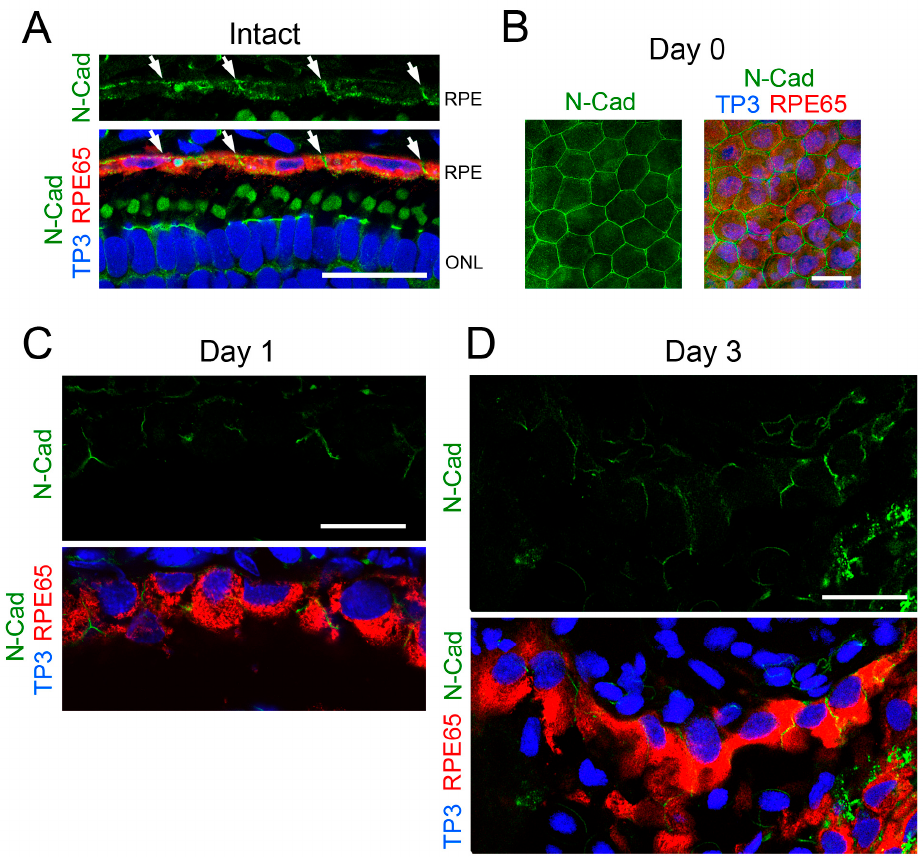
Figure 6. Change in the expression pattern of N-cadherin in RPE cells after retinectomy in vivo. ( A ) Representative N-cadherin immunoreactivity along the RPE layer in the intact eye ( n = 3). Intense immunoreactivity was observed in the region of cell–cell contact in the RPE (arrows). Lower panel: merge of triple stain. RPE65 (red): RPE cells. TO-PRO-3 (TP3; blue): nuclei. ONL: outer nuclear layer; ( B ) Representative N-cadherin immunoreactivity in the RPE sheet of the eye immediately after retinectomy (day 0) ( n = 3). Intense immunoreactivity was observed along the cell membrane which was in contact with neighboring cells. Right hand panel: merge of the triple stain; ( C ) Representative N-cadherin immunoreactivity in RPE cells at 1 day after retinectomy ( n = 5). Lower panel: merge of the triple stain. At this stage, RPE cells still lined along Bruch’s membrane. N-cadherin immunoreactivity was recognized in the region of cell–cell contact; ( D ) Representative N-cadherin immunoreactivity in RPE cells/RPE-derived mesenchymal-like cells at 3 days after retinectomy ( n = 5). Lower panel: merge of the triple stain. At this stage, cell–cell attachment in the RPE became loose but most of the cells still lay on Bruch’s membrane. In those cells, N-cadherin immunoreactivity was recognized along the cell membrane but in most cells the signal was low. Scale = 50 μ m.